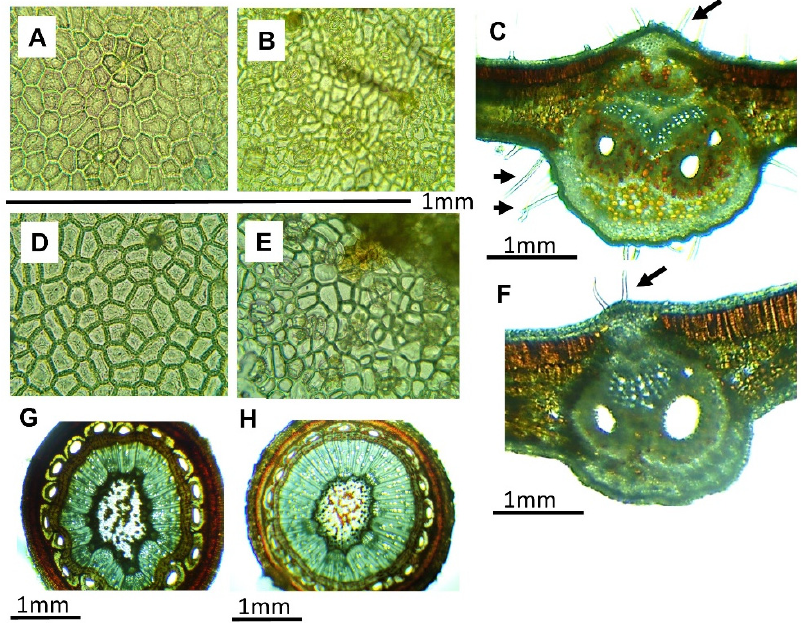
Figure 2. Anatomical description of leaflets and stems of Rhus pachyrrhachis and Rhus virens : ( A ) adaxial epidermis of R. pachyrrhachis observed at 40 × ; ( B ) abaxial epidermis of R. pachyrrhachis at 10 × ; ( C ) cross-section of R. pachyrrhachis leaflet at 10 × ; ( D ) adaxial epidermis of R. virens observed at 40 × ; ( E ) abaxial epidermis of R. virens at 40 × ; ( F ) cross-section of R. virens leaflet at 10 × ; ( G ) cross-section of R. pachyrrhachis stem at 10 × , and ( H ) cross-section of R. virens stem at 10 × . Black arrows indicate positions of